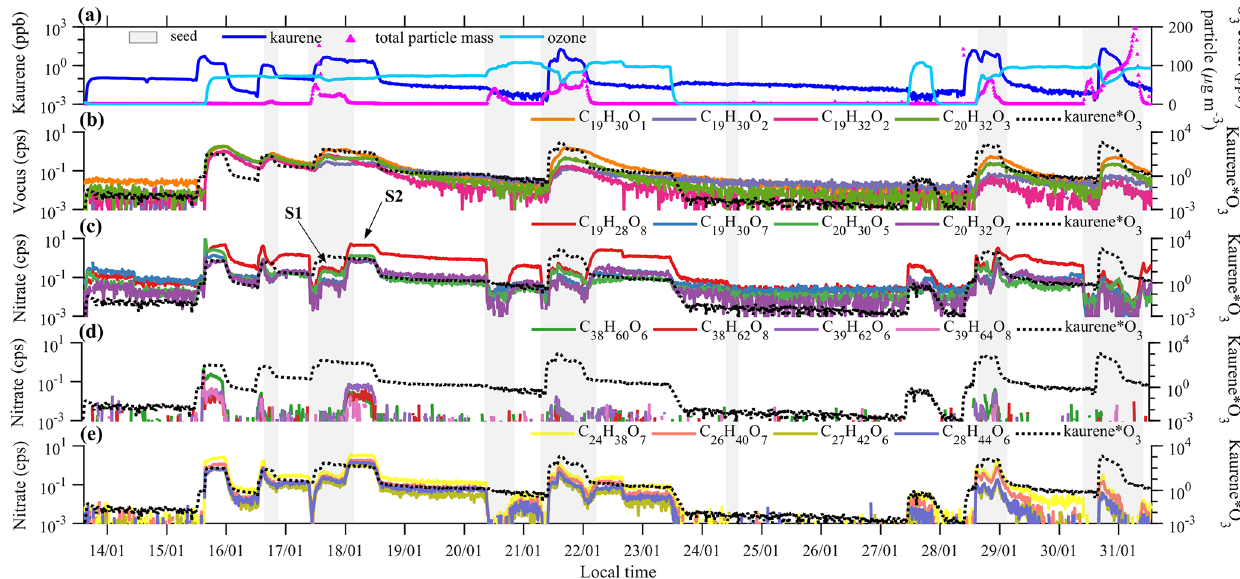
Figure 1. Overview of the measurements from 13–31 January 2020. Panel (a) shows O 3 and corrected kaurene concentrations and the total particle mass calculated from SMPS and AMS measurements. Some of the most abundant oxidation products measured with Vocus are shown in (b) . HOM monomers and dimers of kaurene ozonolysis detected by nitrate CI-APi-TOF are shown in panels (c) – (e) . The light gray shading indicates periods when there were seed particles in the chamber. The black dashed lines are included in each panel to depict the kaurene ozonolysis rate (“Kaurene*O 3 ” in the right y axis represents kaurene concentration times O 3 concentration, in units ppb 2 ). The labels “S1 and “S2” mark two steady-state periods used to determine the condensation behavior of oxidation products (Sect.